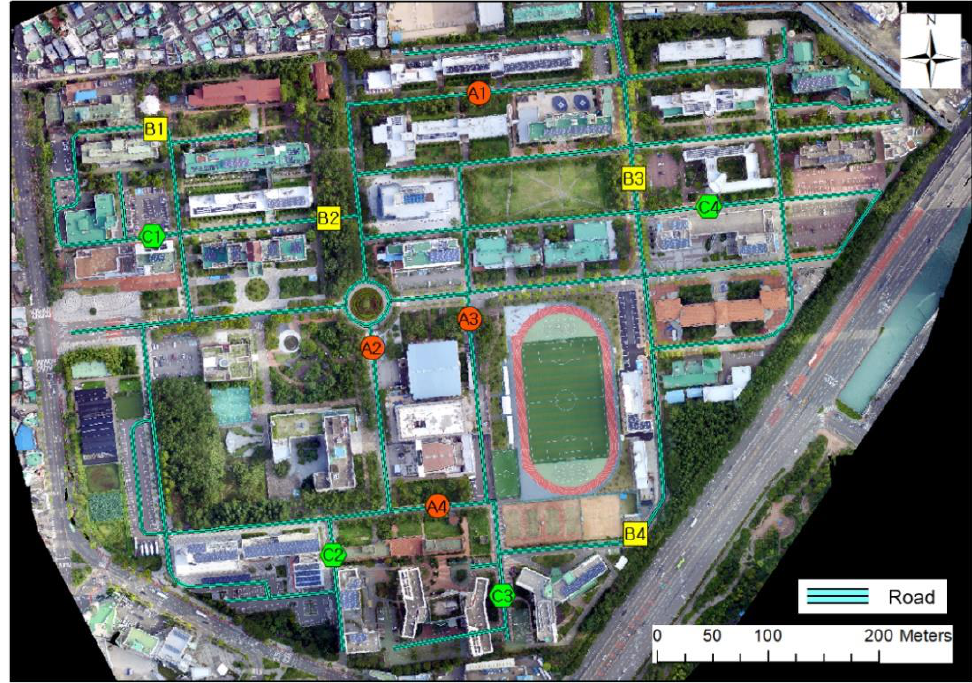
Figure 6. Aerial view of study area. Circular (red), squared (yellow), and hexagonal (green) marks represent the 12 survey points surrounded by (A) only roadside trees, (B) roadside trees and buildings, and (C) only buildings.